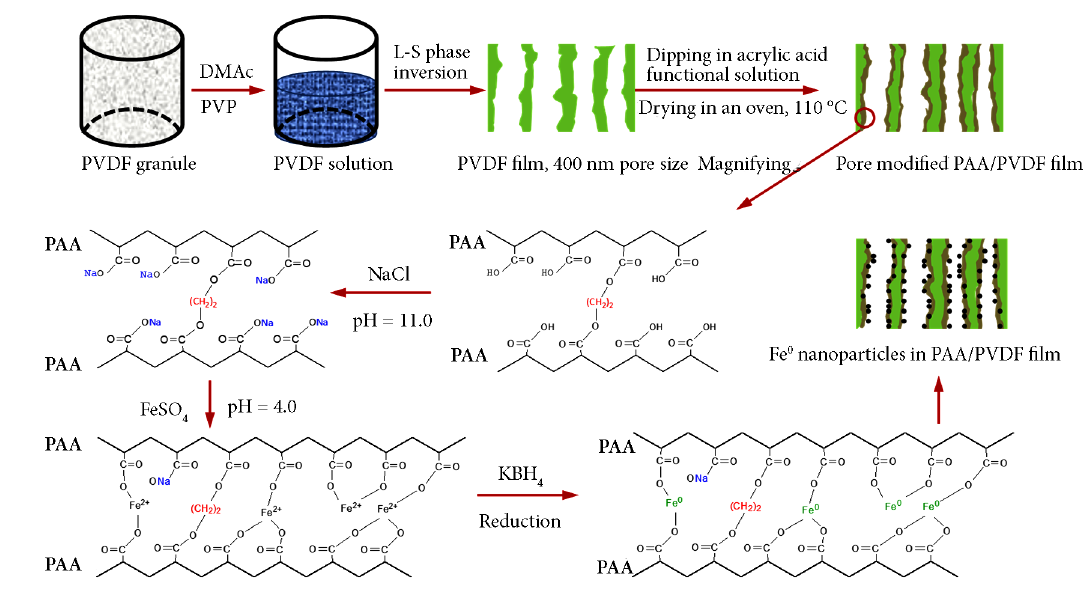
Figure 1. The process of PVDF film preparation and PPN hybrids